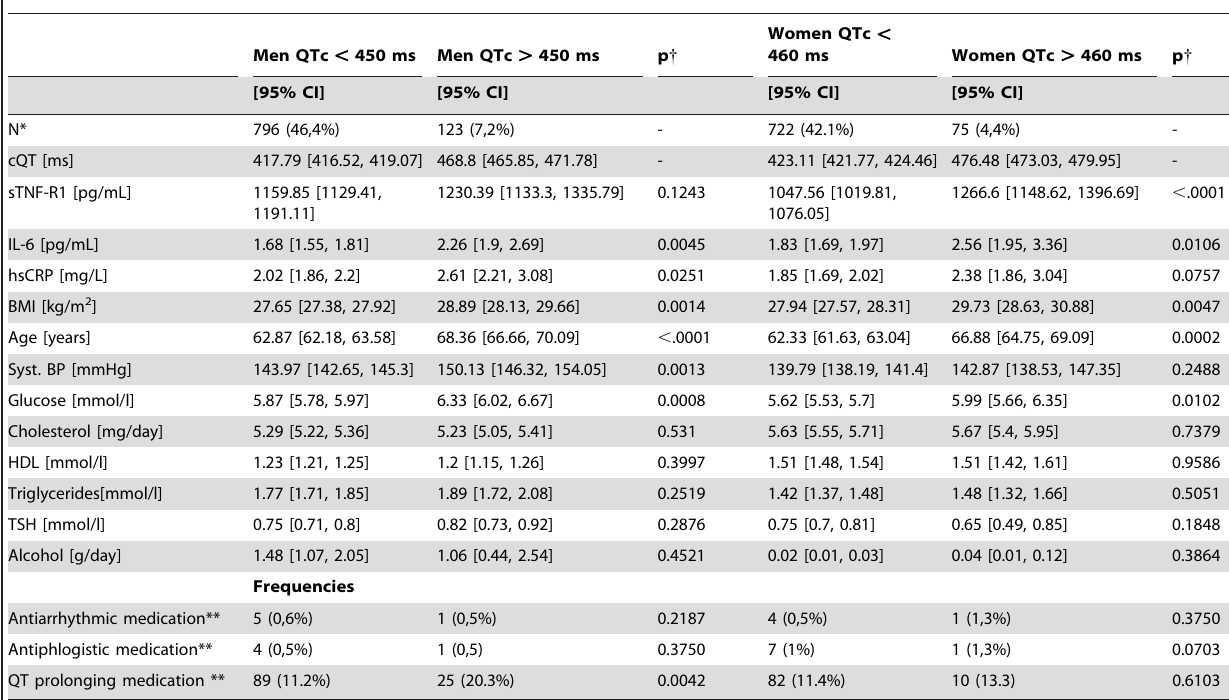
Table 1. Baseline characteristics of the CARLA collective – differentiated according to sex and presence of prolonged QT